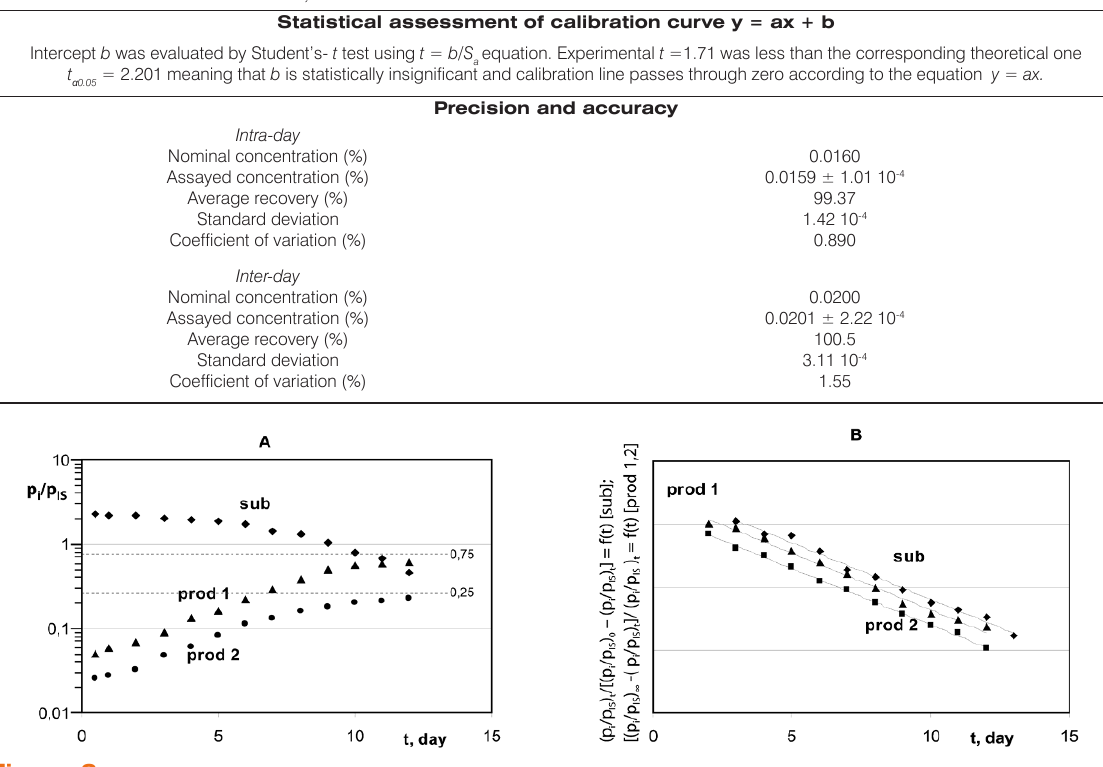
(A) p /p = f(t) plot for IMD degradation [sub] and for the formation of IMD degradation products [prod I, prod II] in solid state i IS (T = 363 K, RH = 76.4%). (B) Semi-logarithmic plot of solid state IMD degradation (p degradation products formation [(p